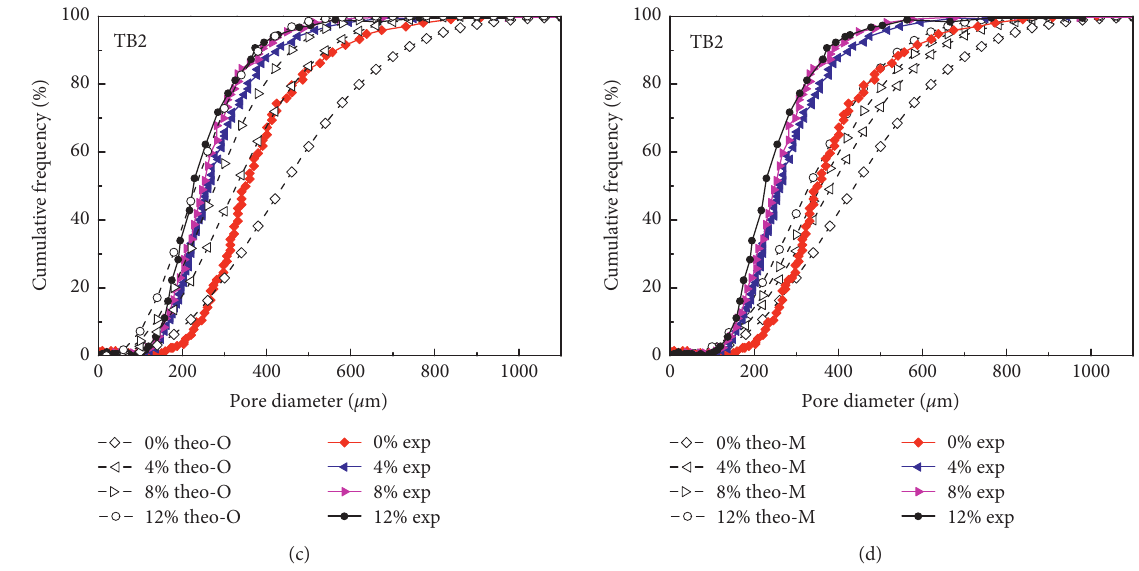
Figure 9: Experimental and theoretical PSDs of TB1 and TB2. (a) Experimental and theoretical PSDs of the original model for TB1. (b) Experimental and theoretical PSDs of the modified model for TB1. (c) Experimental and theoretical PSDs of the original model for TB2. (d) Experimental and theoretical PSDs of the modified model for TB2 (data of experimental and theoretical PSDs of the original model sourced from reference [13]).